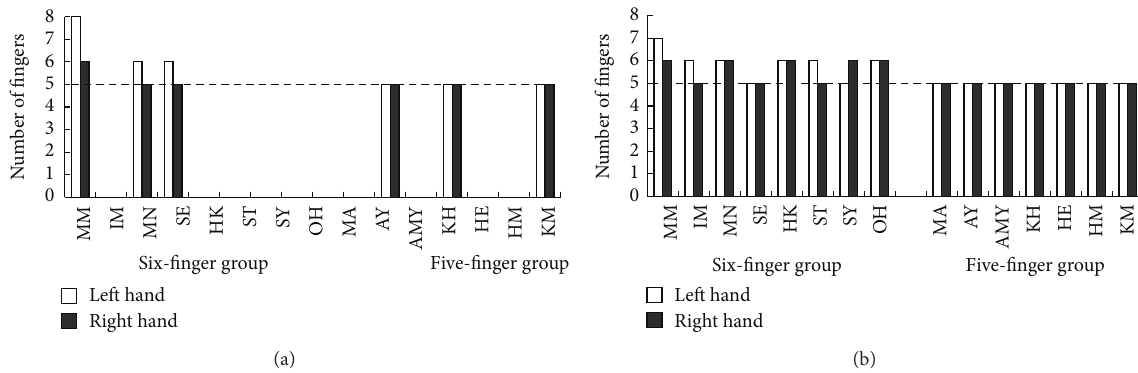
Figure 3: The number of fingers in each patient group. (a) The number of fingers for hands-down human figures drawn by each patient. Most of patients did not draw fingers in detail. (b) The number of fingers for hands-up human figures drawn by each